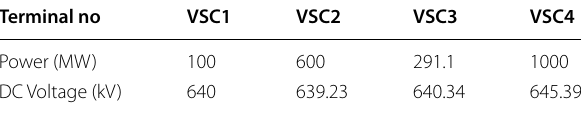
Table 2 Initial steady-state conditions of the MTDC